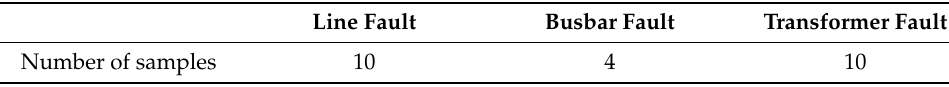
Table 2. TS2000 simulation system training sample composition.